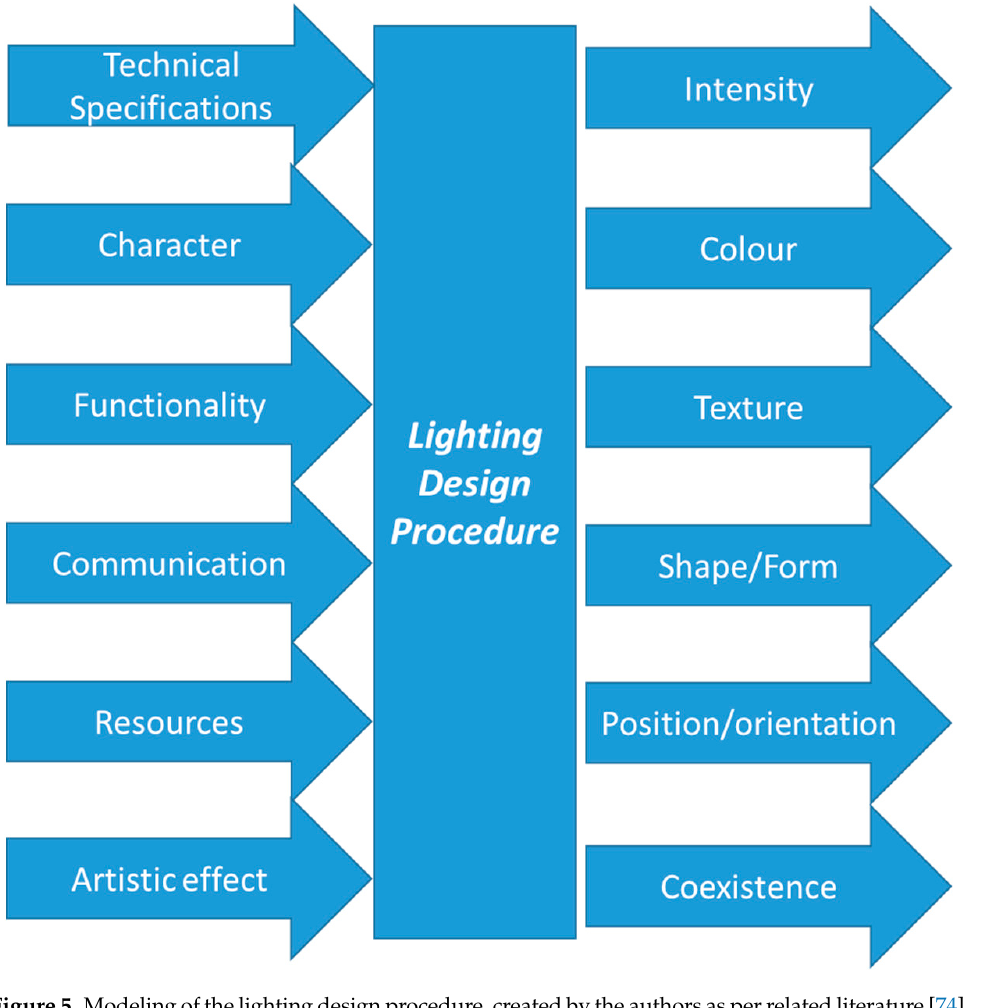
Figure 5. Modeling of the lighting design procedure, created by the authors as per related literature [74].